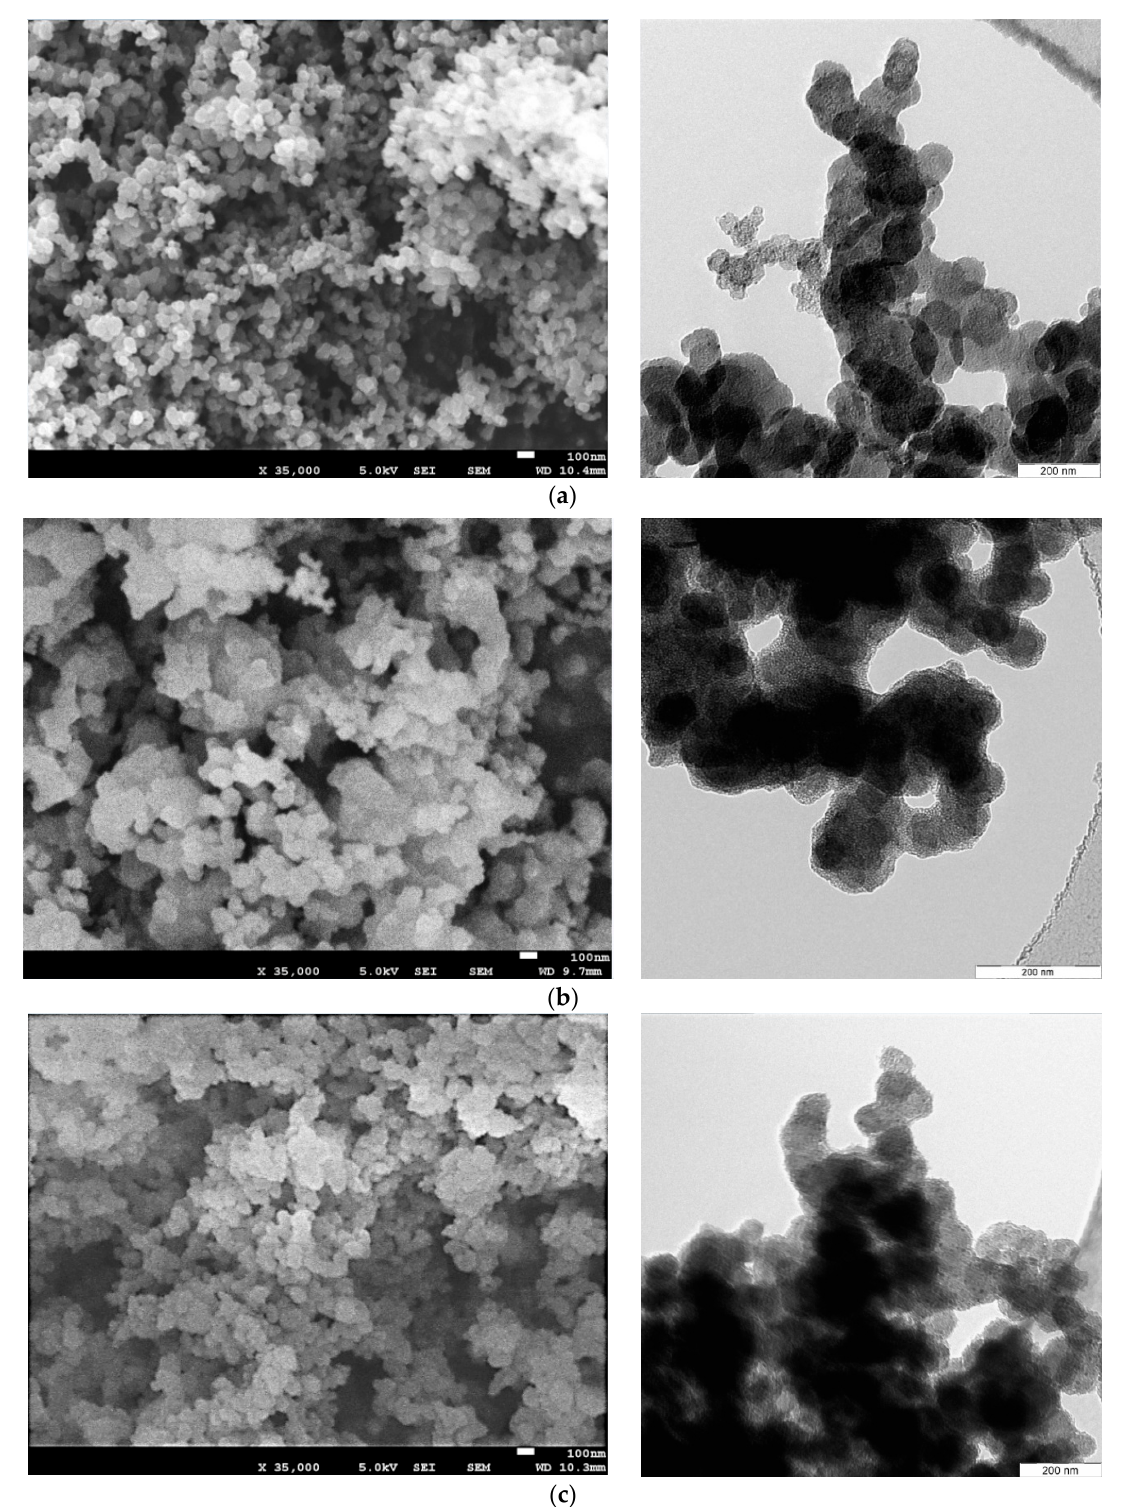
Figure 3. SEM/TEM images of ( a ) Ru/CB, ( b ) Ru/CB@SiO 2 (C), and ( c ) Ru/CB@SiO 2 (P). Figure 3. SEM / TEM images of ( a ) Ru / CB, ( b ) Ru / CB@SiO 2 (C), and ( c ) Ru / CB@SiO 2